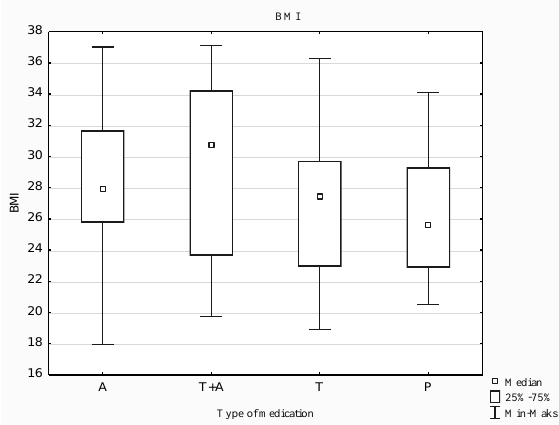
Figure 4. The BMI and the type of taken